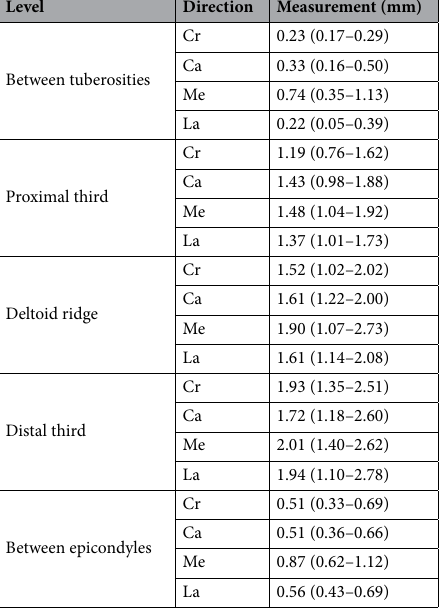
Table 3. Micro-CT cortical thickness measurements in the cranial (Cr), caudal (Ca), medial (Me) and lateral (La) directions of the koala humerus at the five measurement levels represented as mean with 95% confidence